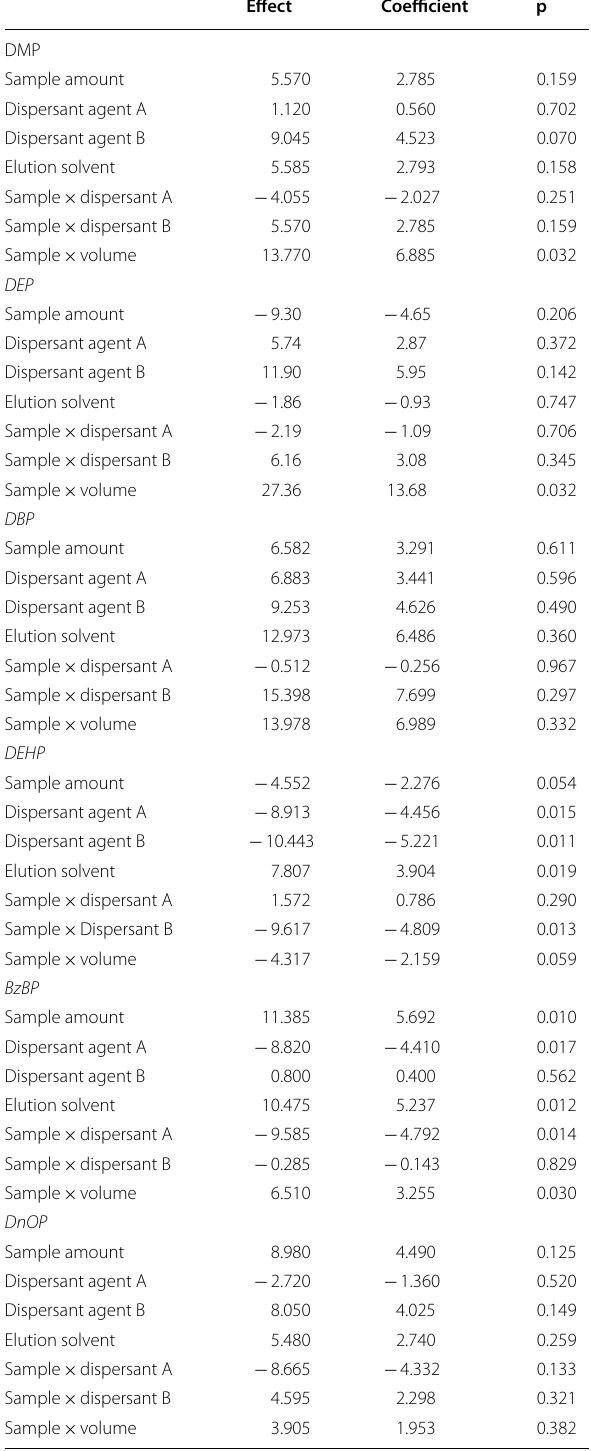
Table 3 Analysis of